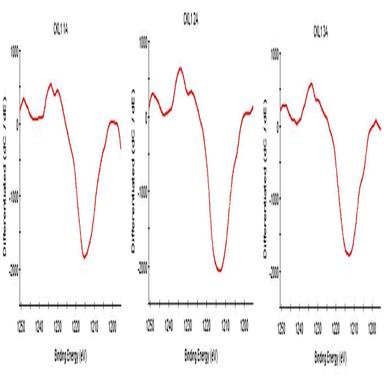
Differentiated C KLL Auger peak of 1A, 1B, and 1C.